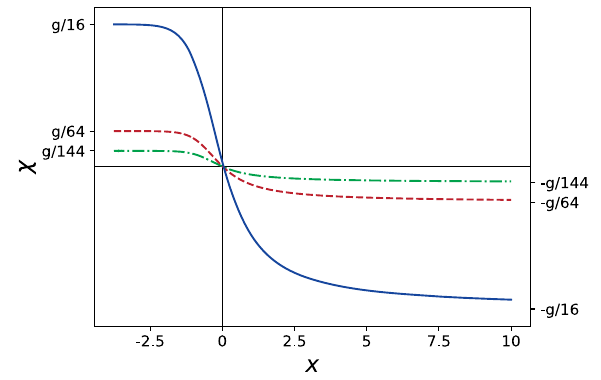
Fig. 3 Bound states for three values n = 1 , 2 ,